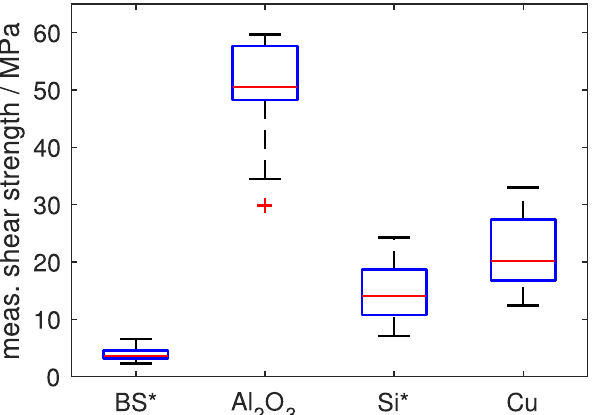
Figure 5. Shear strength measured for the different substrate materials represented as Tukey-type box plots. (*) For borosilicate glass (BS) and Si, the shear strength is defined by the failure of the substrate and not of the bond; red: median value, blue: lower (25%) and upper (75%) quartile; whiskers: maximum 1.5 inter-quartile range, red cross: